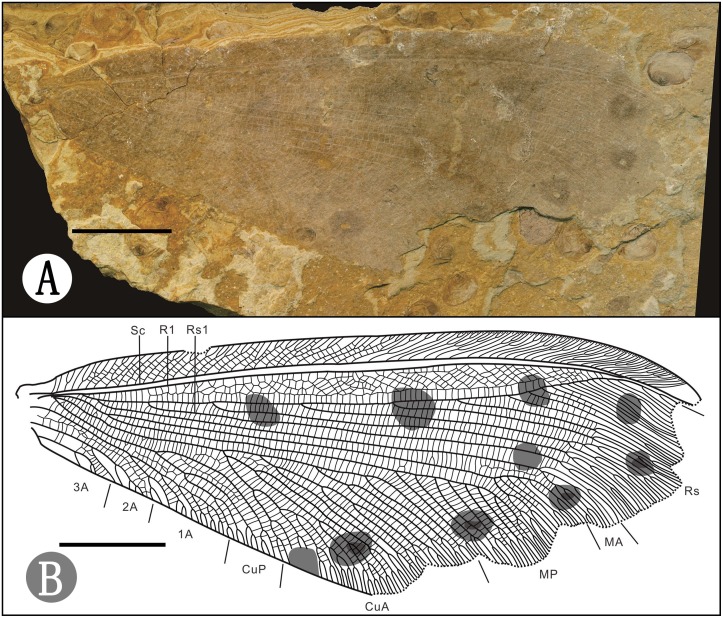

Ulrikezza sp., CNU-NEU-NN2015002A. Photograph; B. Outline of holotype for the forewing. Scale bar = 10 mm.